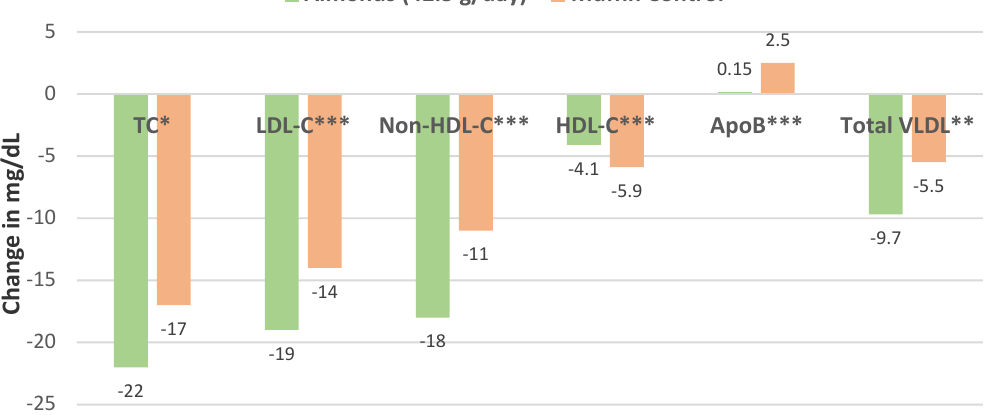
Figure 28. Effect of heart-healthy diets with raw almonds or a muffin control in hyperlipidemic individuals from baseline to 6 weeks, * p = 0.04, ** p = 0.02, and *** p < 0.01 [53]. Table 5. Changes in blood lipids from baseline: National Cholesterol Education Program (NCEP) Step 3 diet with almonds vs. without almonds in subjects with statin therapy [58].